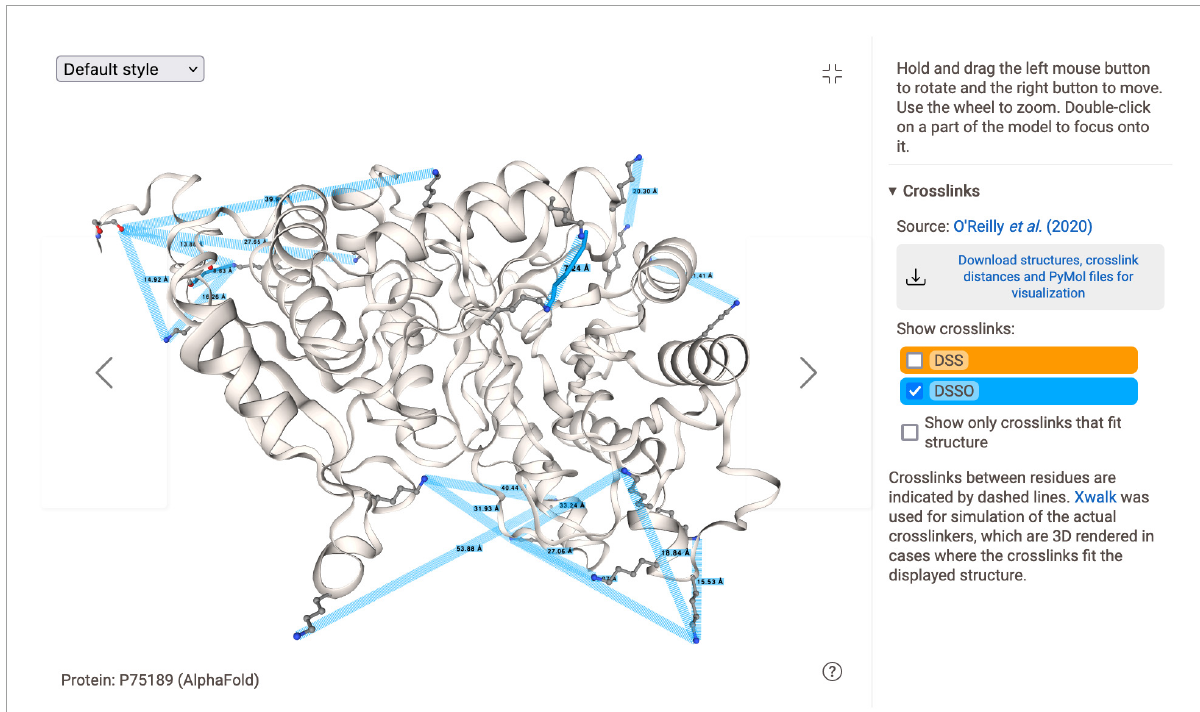
FIGURE6 Fullscreen view of the Structure Viewer , which can be found on the sidebar of gene pages. It displays interactive 3D representations of available protein structures loaded from PDB or AlphaFold DB, and can also feature visualizations of internal cross-links. Using the control panel to the side of the view canvas, the visibility of cross-links can be toggled. The screenshot shows the AlphaFold structure prediction for eno and corresponding